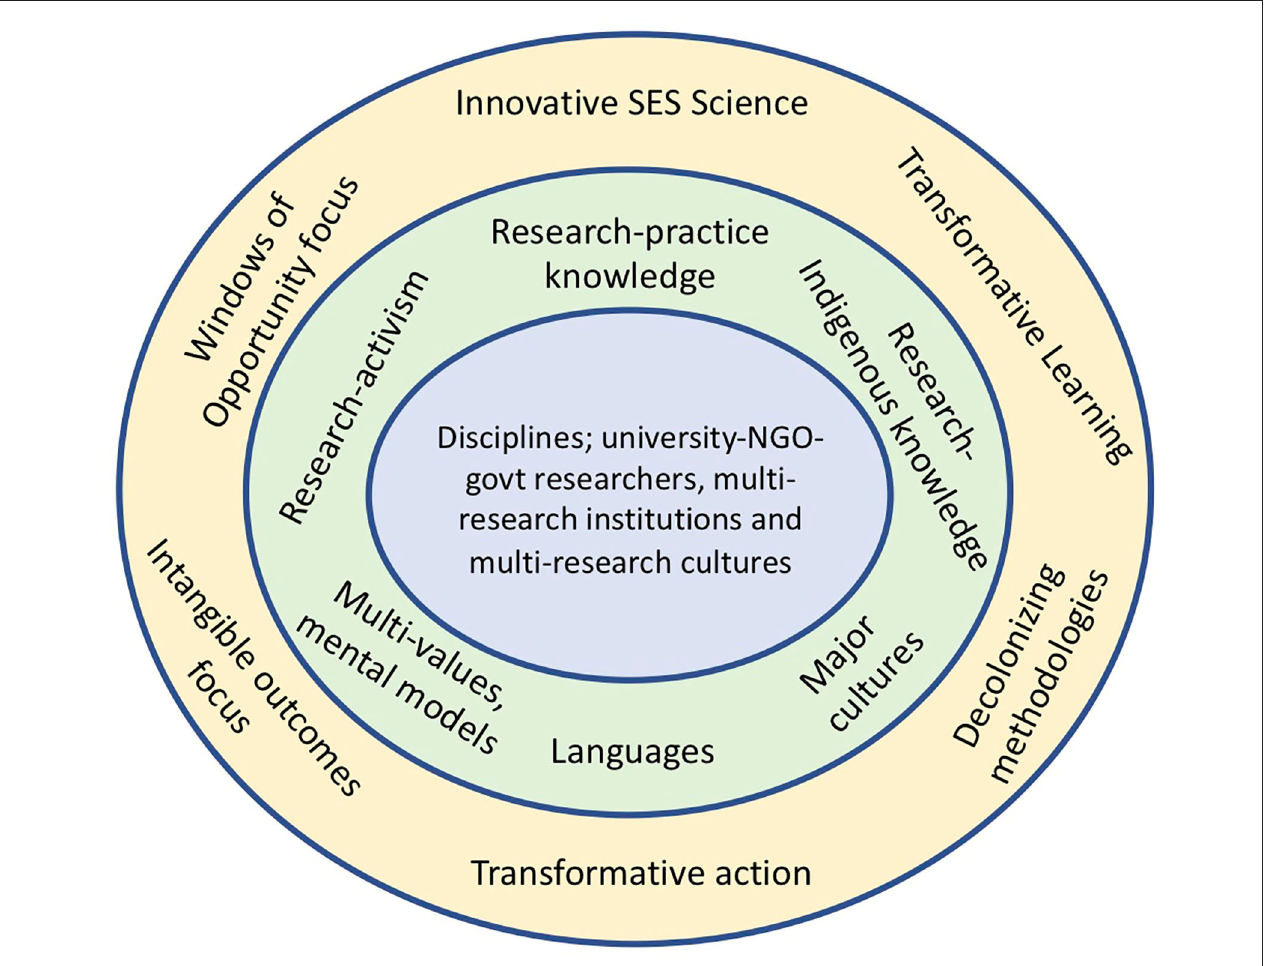
FIGURE 3 | The increasing complexity of boundary spanning when moving from interdisciplinary (blue center circle) to science with society (green middle ring). The outer orange ring is not boundary spanning, but rather the next evolution of the practices/strategies that could make science with society more transformative.